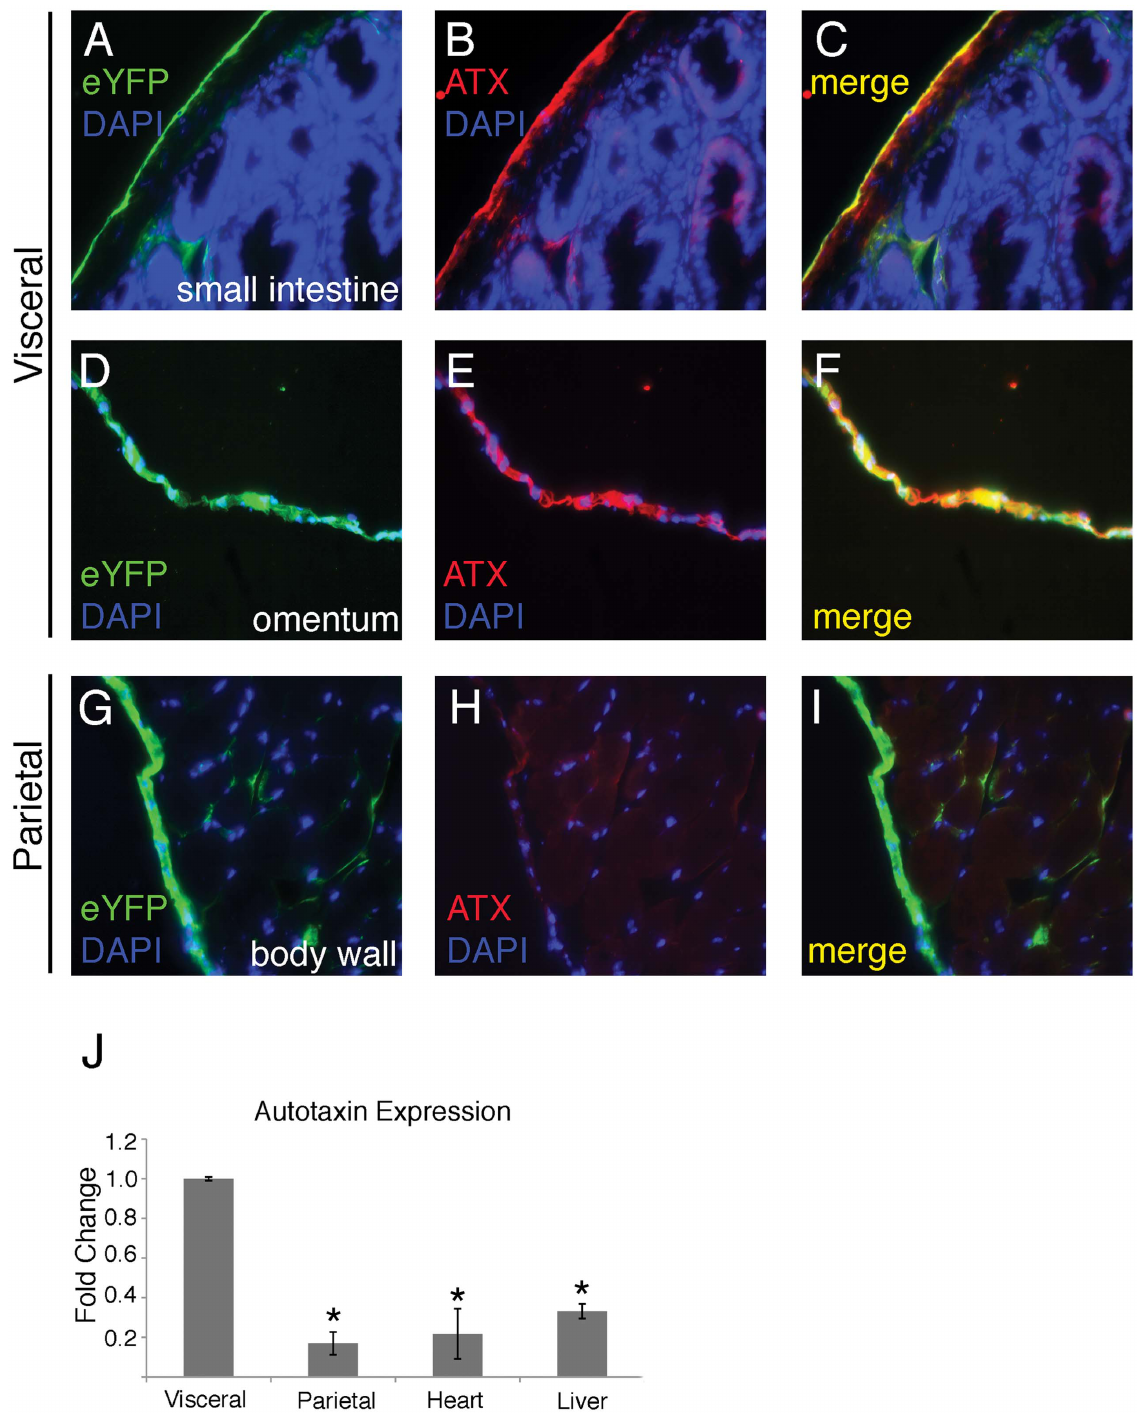
Figure 2. Autotaxin is expressed at significantly higher levels in visceral mesothelia compared to parietal. Immunofluorescence was used to detect autotaxin (ATX) expression in visceral and parietal tissues from Wt1 cre/ + ; R26R eYFP/ + reporter mice. Cells that express Wt1, a mesothelial marker, will express enhanced yellow fluorescent protein (eYFP) that can be detected with a green fluorescent protein (GFP) antibody (A, D, G). Robust autotaxin expression is evident in visceral mesothelia (A–F). In contrast, the parietal mesothelium that lines the body wall expresses the mesothelial marker (G), but is devoid of autotaxin expression (H). Nuclei are marked with DAPI. Quantitative real-time RT-PCR was used to determine autotaxin transcript levels in visceral (omental) mesothelium, parietal mesothelium, heart, and liver (J). The autotaxin expression in visceral cells was set to 1 and fold changes were calculated for each subsequent tissue type. The asterisk represents a statistically significant difference when compared to the expression level in visceral cells (p , 0.05, n=4). Error bars were calculated using standard error of the mean.